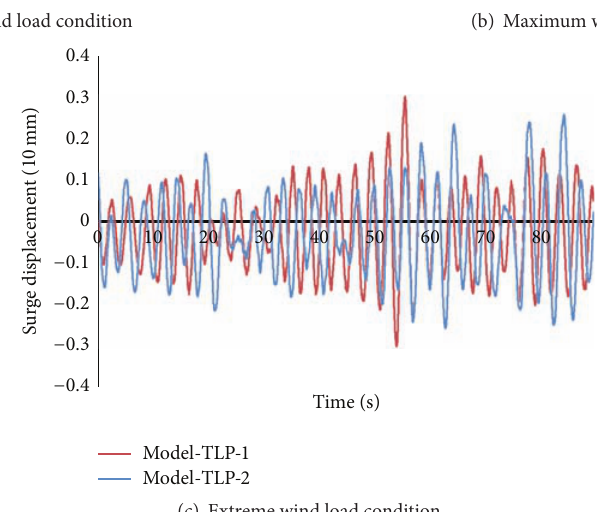
Figure 13: Model-TLP-1 and model-TLP-2 surge displacement for different load